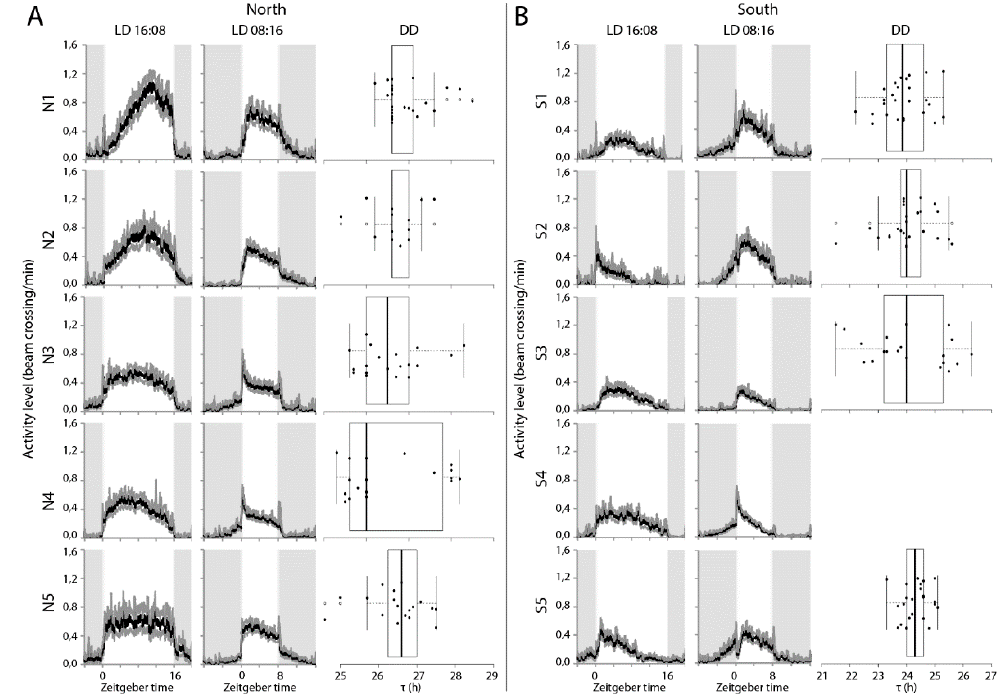
Figure 4. ( A ) Locomotor activity profiles for isogenic lines derived from Oulu (65 ◦ N) (N1, N2, N3, N4, N5) and ( B ) from Corsica (45 ◦ N) (S1, S2, S3, S4, S5) at long (LD16:08) and short (LD 08:16) day regimes. Grey shading indicates the night phase and white shading indicates the day phase. Zeitgeber time is indicated along the X-axis and ZT0 represents the time of light turn-on. Activity was calculated as average of bin crosses / minute of 25–32 individuals each over 24 h periods. Box plots represent the free running period ( τ ) in constant darkness (DD). Box plots depict the median (thick horizontal line within the box), the 25th and 75th percentiles (box margins) and the 1.5 interquartile range (thin horizontal line). Note that Line S4 is not rhythmic under DD. Note di ff erent scale on x-axis for A and B panels.